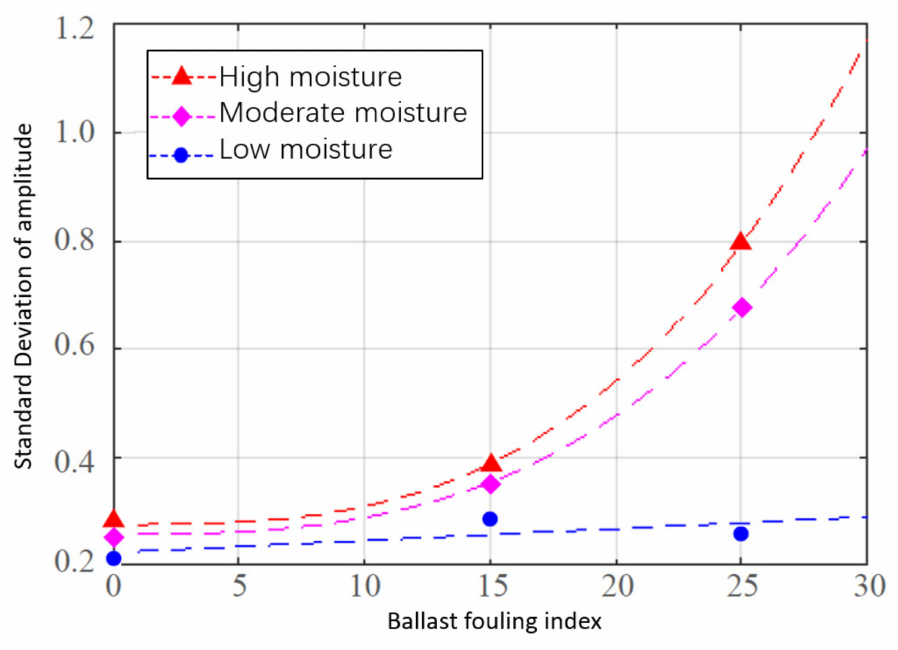
Figure 13. Relationship between the GPR fouling index and air-ballast reflection amplitude